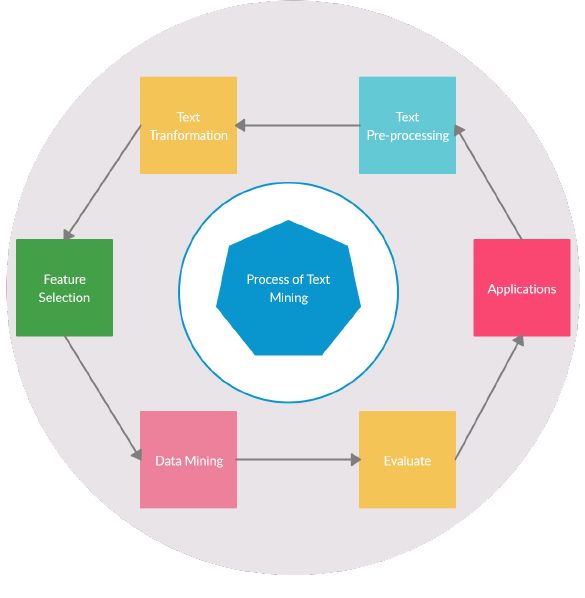
Figure 1. Process of Text